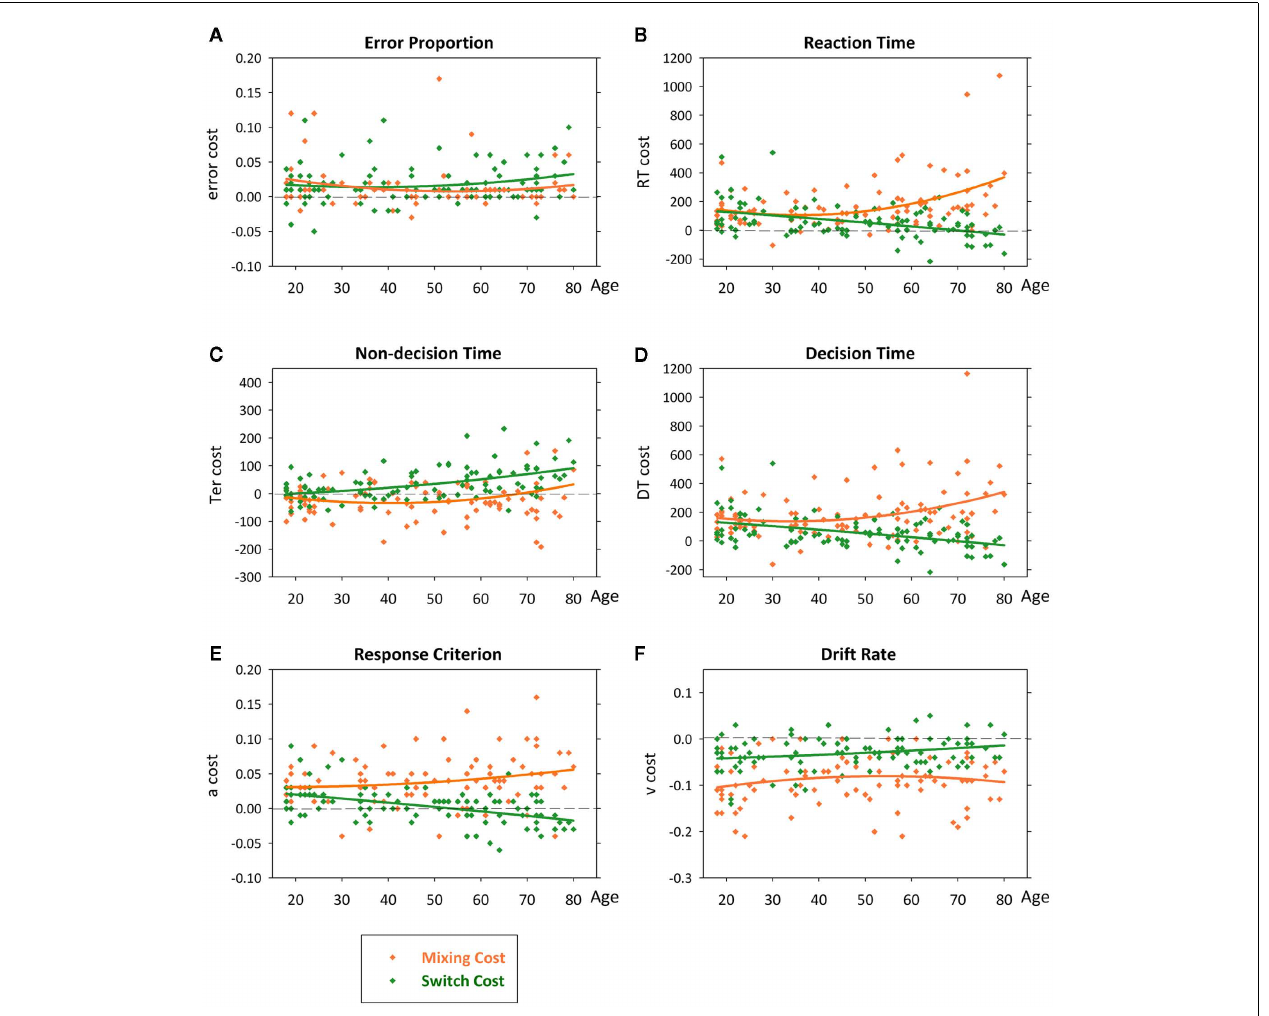
FIGURE 4 | Scatterplots of error rate (A), reaction time (B), non-decision time (C), decision time (D), criterion (E) and drift rate (F) as a function of age with quadratic lines of best fit. Effects remained highly significant when outlier for DT mixing cost was removed.